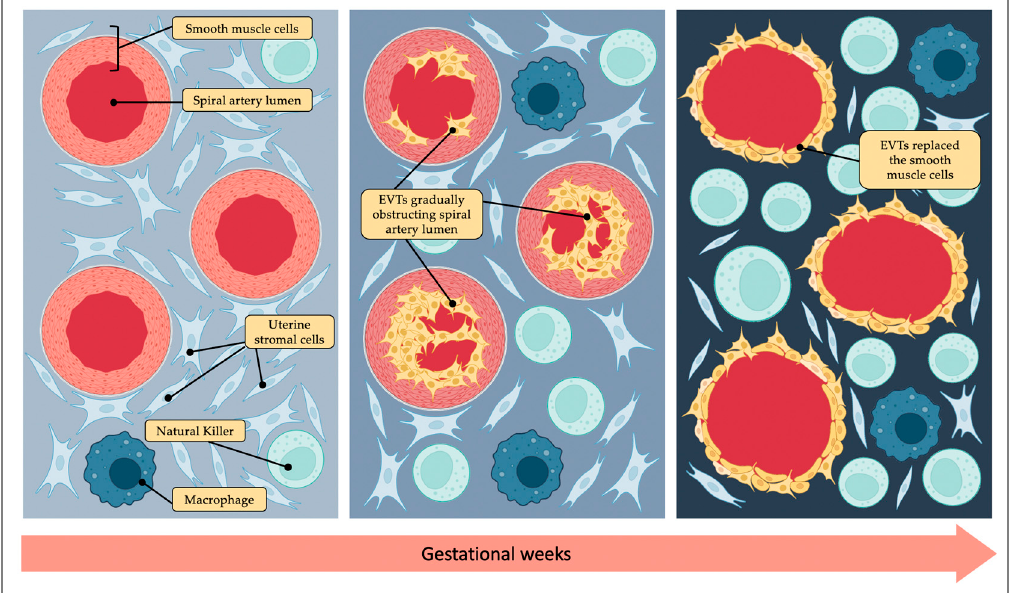
Figure 2. Spiral artery remodeling. Extravillous cytotrophoblast cells (EVTs) invade spiral arteries’ vascular lumen and replace the smooth muscle cells. In the first stage of this process, EVTs aggregate within the vasal lumen, causing arterial obstruction. Then, at the end of the first trimester, blood flow reaches the intervillous space, and spiral arteries mutate into low-resistance and high-capacity vessels, reaching a 5–10-fold dilation. At the same time, as gestational weeks go by, decidual is enriched with natural killers and macrophages.